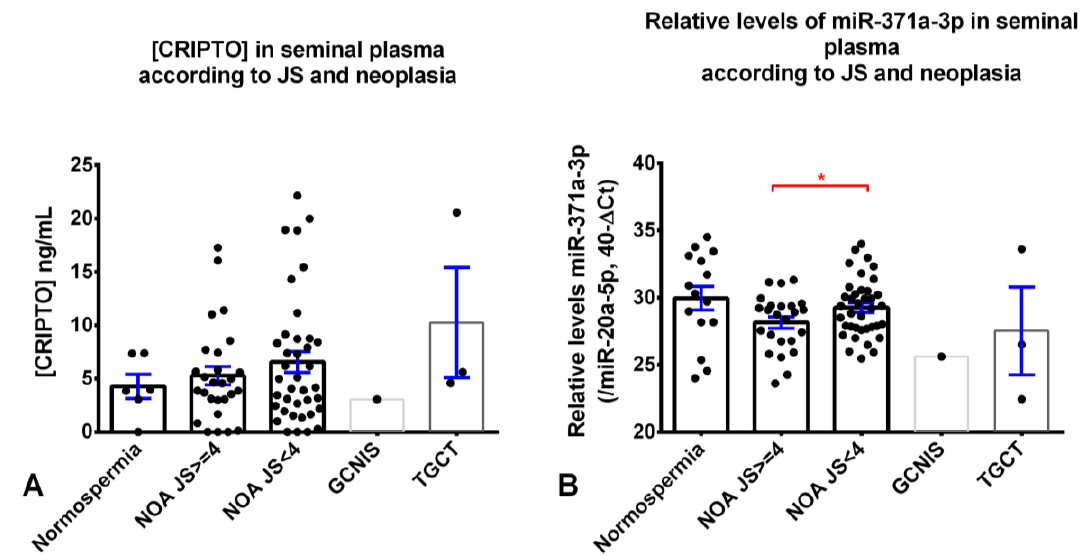
Figure 5. CRIPTO concentration (( A ) Kruskal–Wallis test p -value = 0.5632) and miR-371a-3p relative levels (( B ) Kruskal–Wallis test p -value = 0.1495) in various seminal plasma samples. Comparison of di ff erent samples, including those from men with normospermia, non-obstructive azoospermia with di ff erent Johnsen’s scores, and with GCNIS / TGCT. Relative levels of miR-371a-3p were normalized with miR-20a-5p and plotted in the 40- ∆ Ct format. Error bars represent mean ± S.E.M. Abbreviations: JS—Johnsen’s score; NOA: non-obstructive azoospermia; GCNIS - germ cell neoplasia in situ; TGCT—testicular germ cell tumor. * p < 0.05. For CRIPTO testing, only six seminal plasma samples were available, while 15 were available for miR-371a-3p testing.